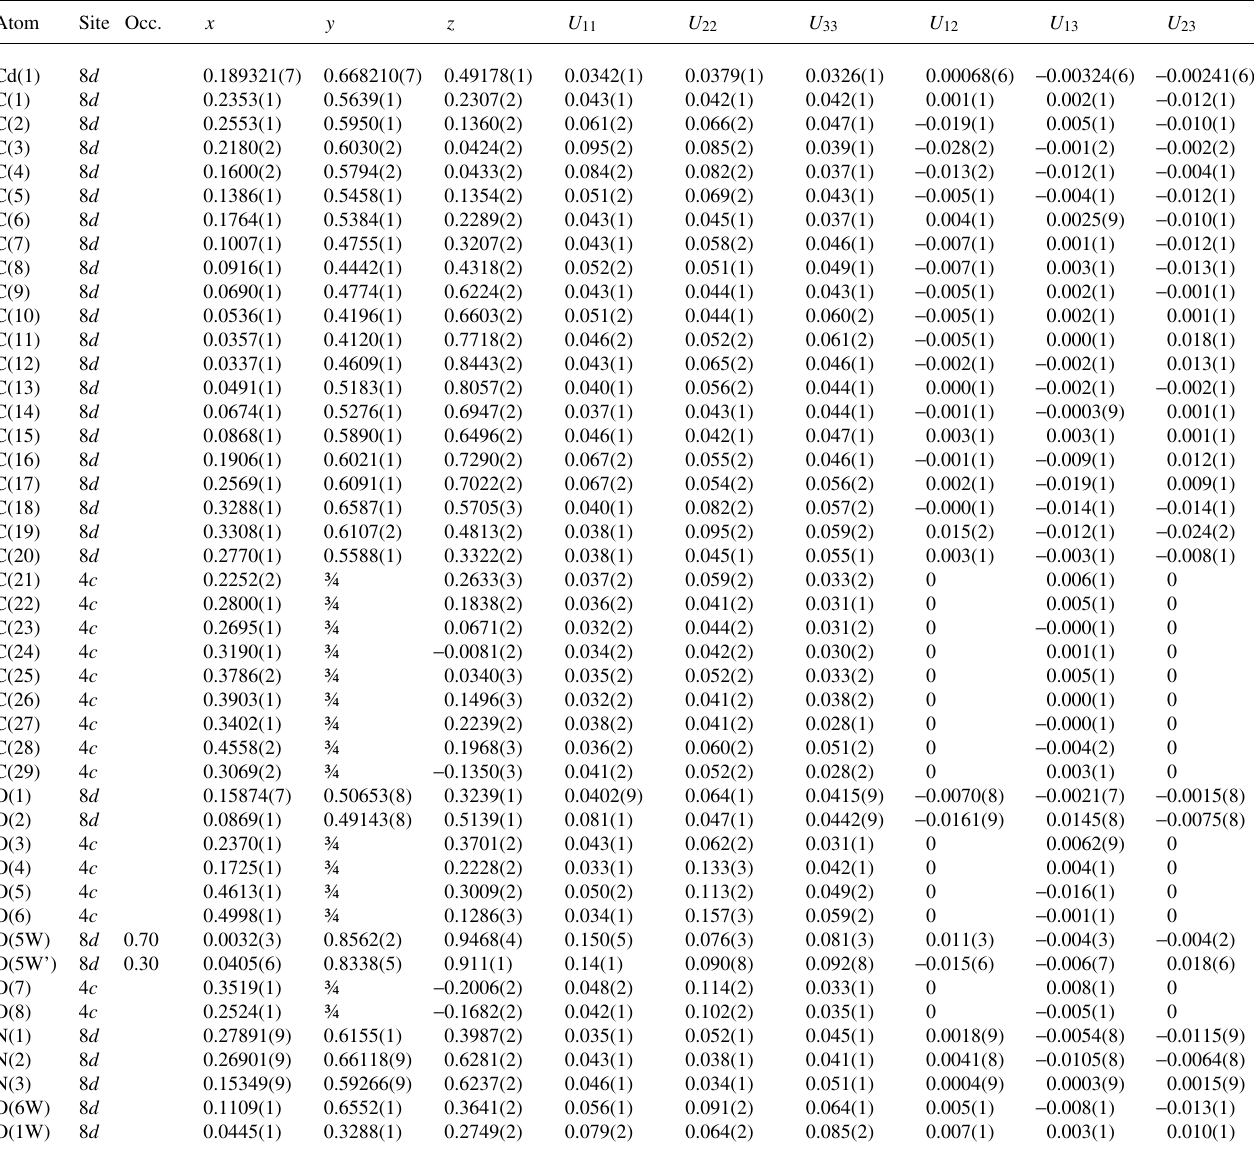
Table 3. Atomic coordinates and displacement parameters (in Å 2 )